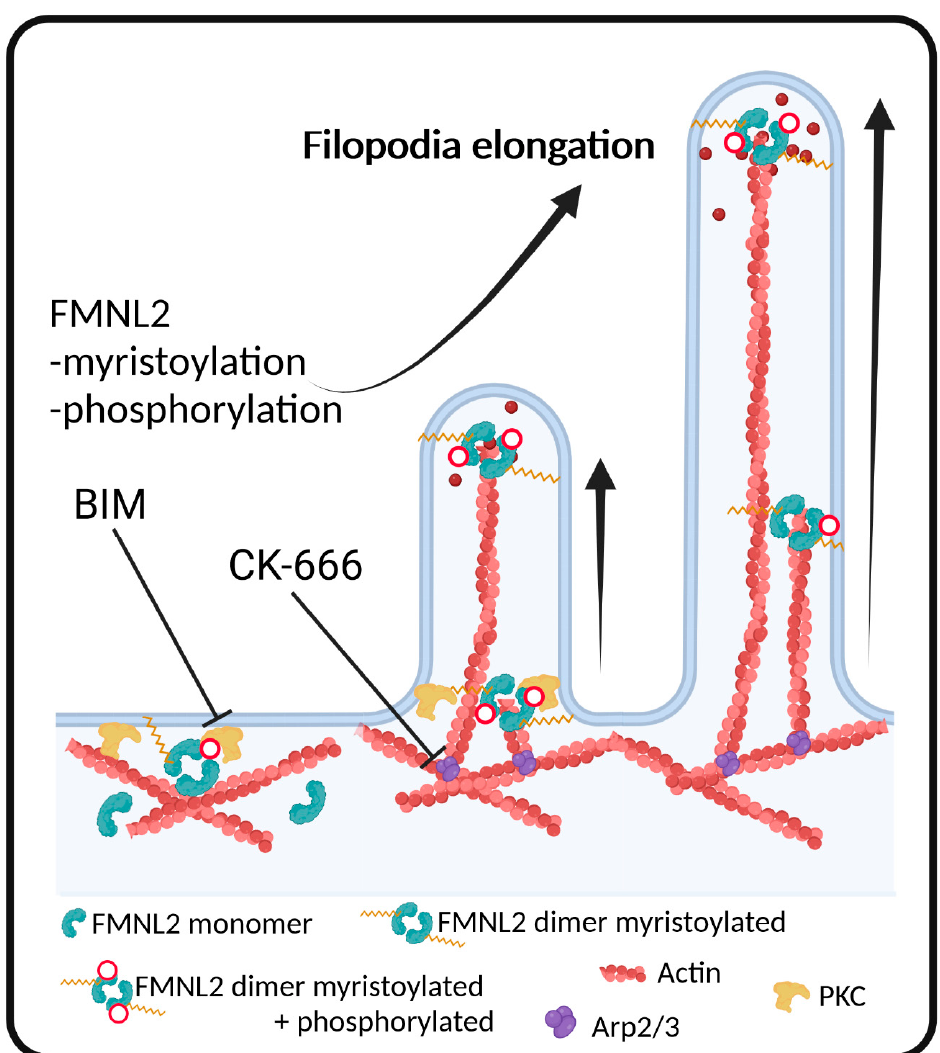
Figure 5. Model of FMNL-phosphorylation-dependent filopodia formation. Filopodia are assembled at the plasma membrane where actin, FMNL2 dimers and PKCs are present. N-terminal myristoylation enables plasma membrane anchoring of FMNL2. The formin is released from its autoinhibited state through phosphorylation by PKC α . Following Arp2/3 complex-mediated nucleation of actin filaments, myristoylated and phosphorylated FMNL2 localizes at the filopodial tip and further elongates the filopodia. Inhibition of the Arp2/3 complex with CK-666 or PKC activity with BIM reduces the overall filopodia growth rate and formation. Figure was created using BioRen- der.com. Supplementary Materials: The following supporting information can be downloaded at: www.mdpi.com/xxx/s1, Video S1: MCF10A FMNL2 KO rescue cells stably re-expressing FMNL2- GFP display FMNL2 at the tip of growing filopodia. Cells were transfected with actin-chromobody SNAP (white, SNAP-cell 647 SiR). Scale bar = 500 nm.